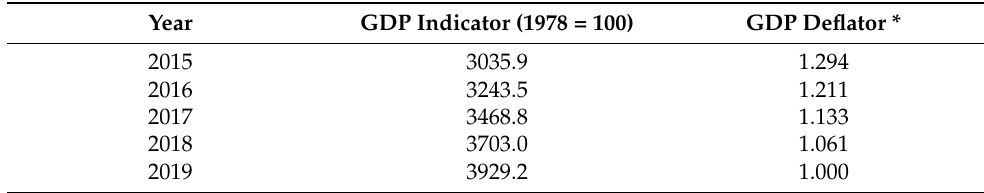
Table 1. GDP indicator and GDP deflator in China for